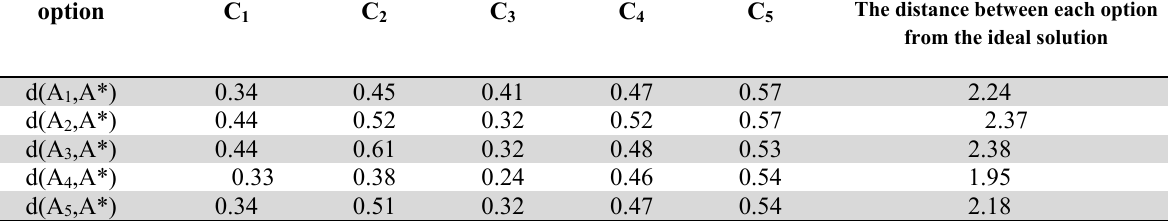
The distance between each option from the ideal solution option 1 C 2 C 3 C 4 C 5 C